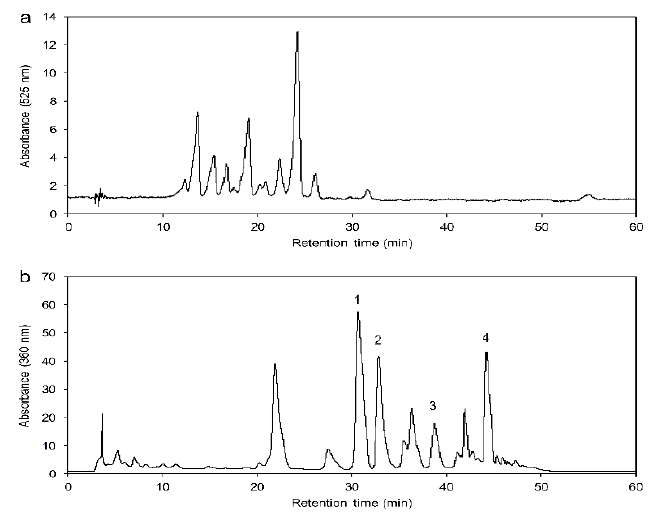
Figure 1. HPLC chromatogram for anthocyanins ( a ) and flavonols ( b ) in a sample Figure 1 . HPLC chromatogram for anthocyanins ( a ) and flavonols ( b ) in a sample extract.